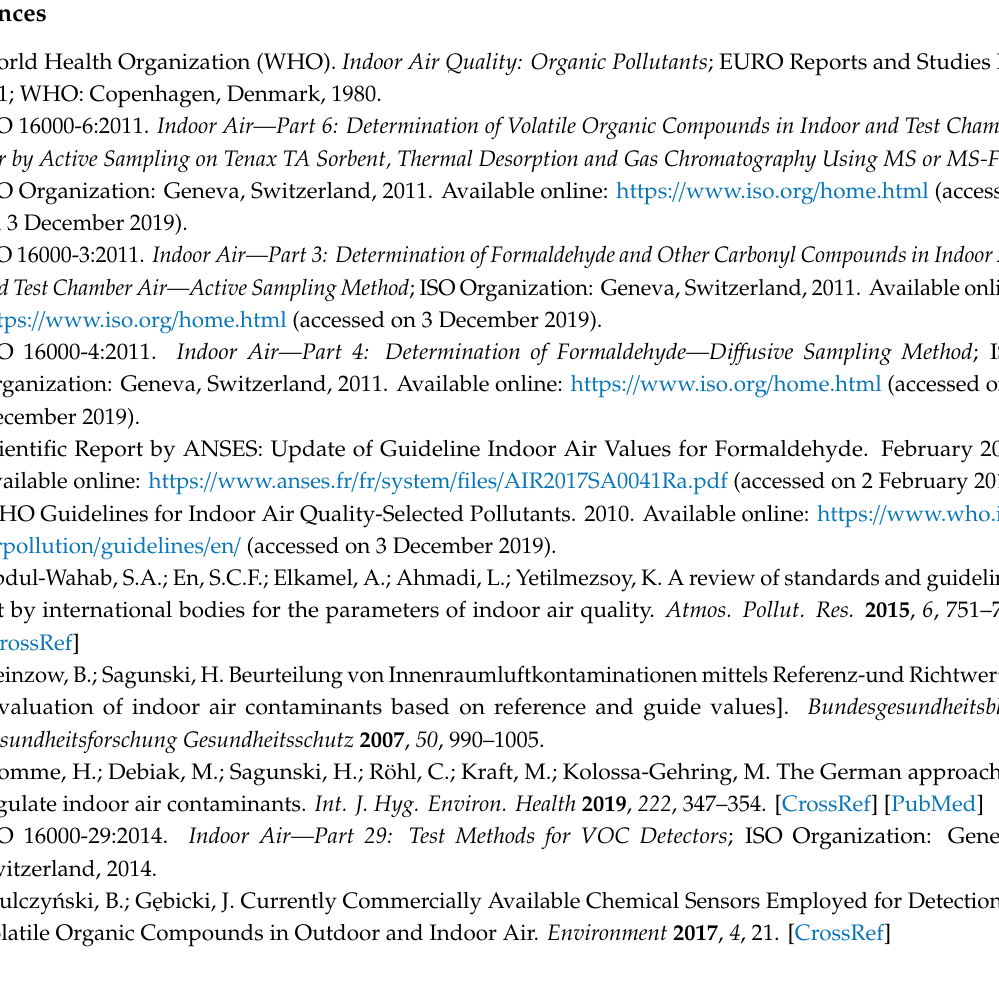
Figure S1: six meeting rooms in SGRI building used during the preliminary investigation, Table S1: VOCs and TVOC reference measurements of the di ff erent rooms in the full scale chamber trials during TVOC sensor